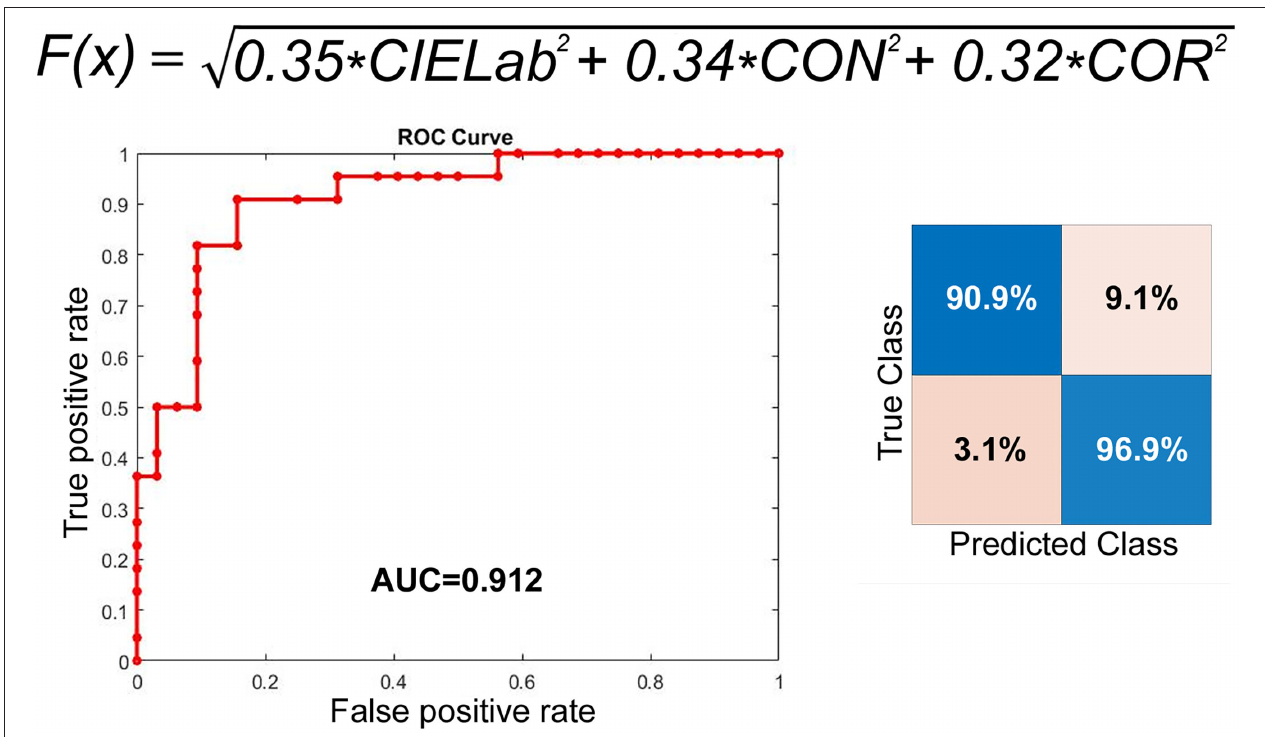
FIGURE 3 | ROC curve of our function index to predict post-intubation larygneal inflammation. Our measurement has a sensitivity of 90.9% and a specificity of 96.9%.